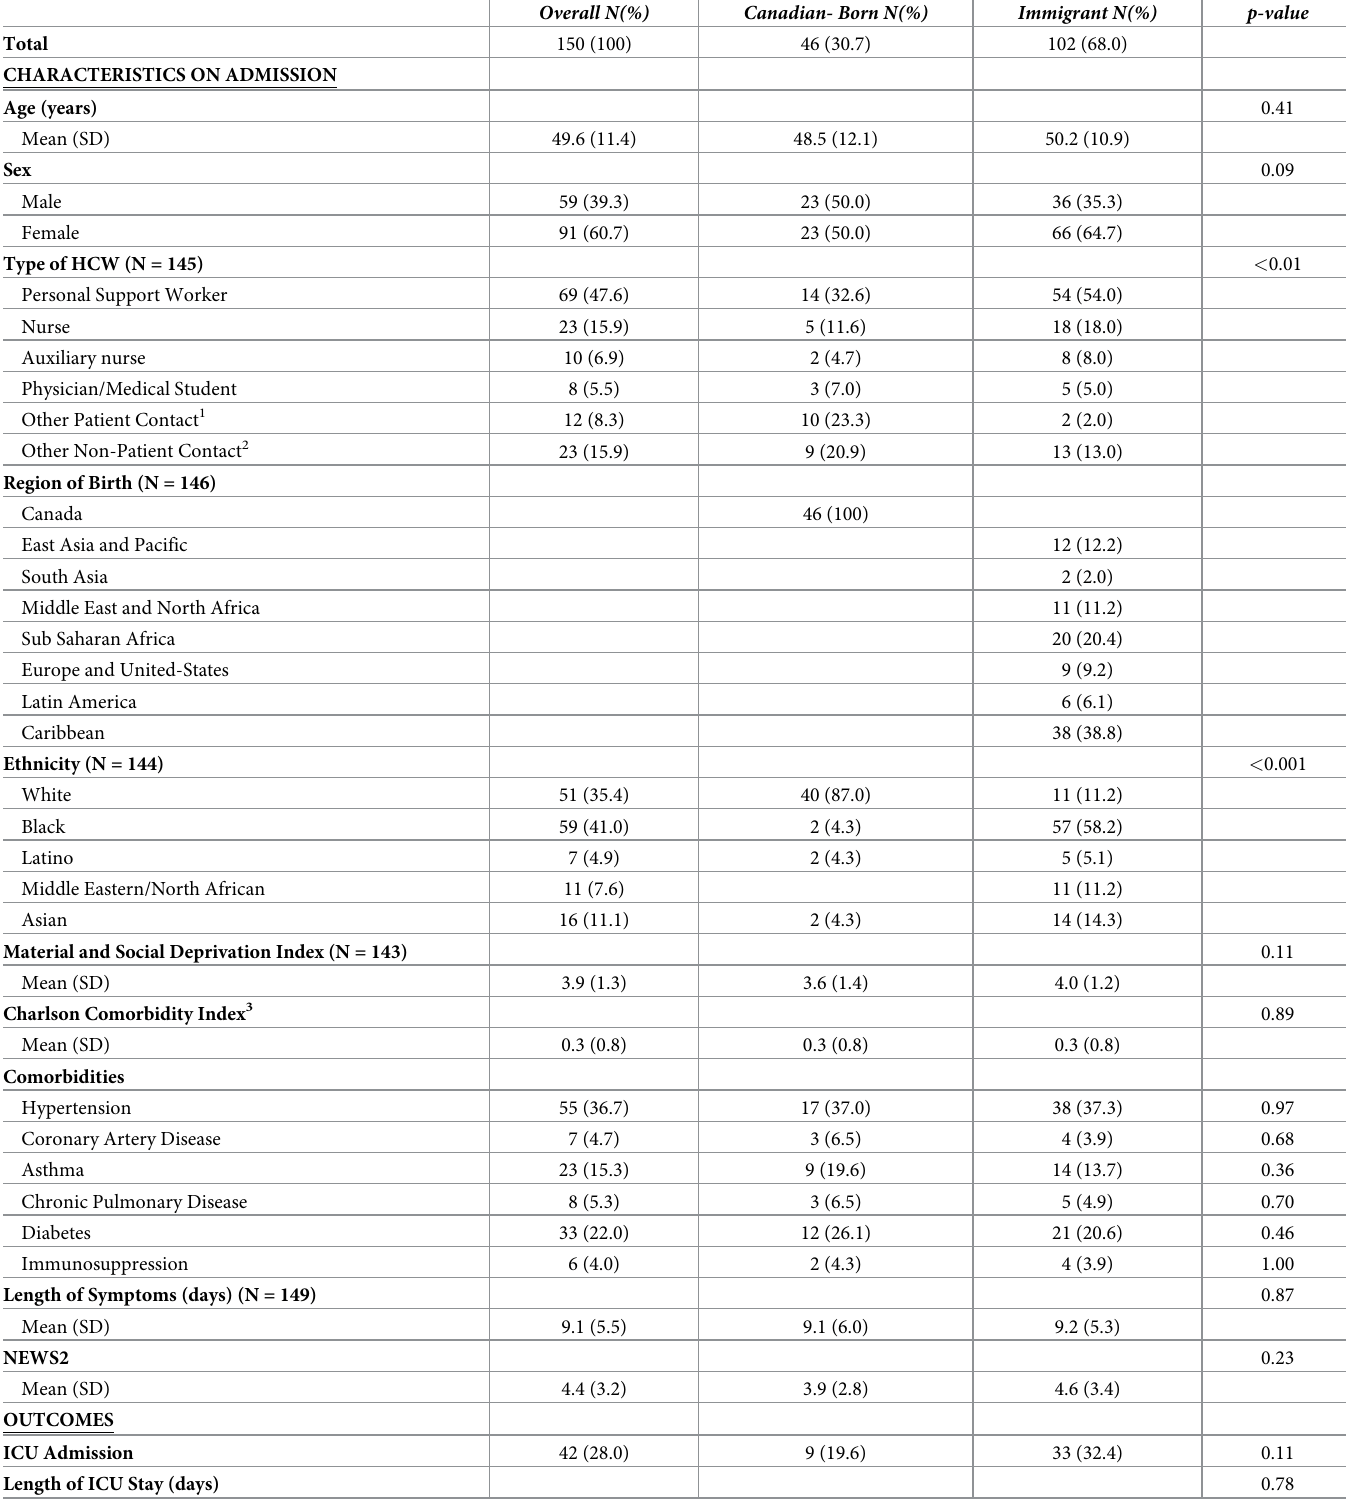
Table 2. Health care worker chart review data stratified by immigration